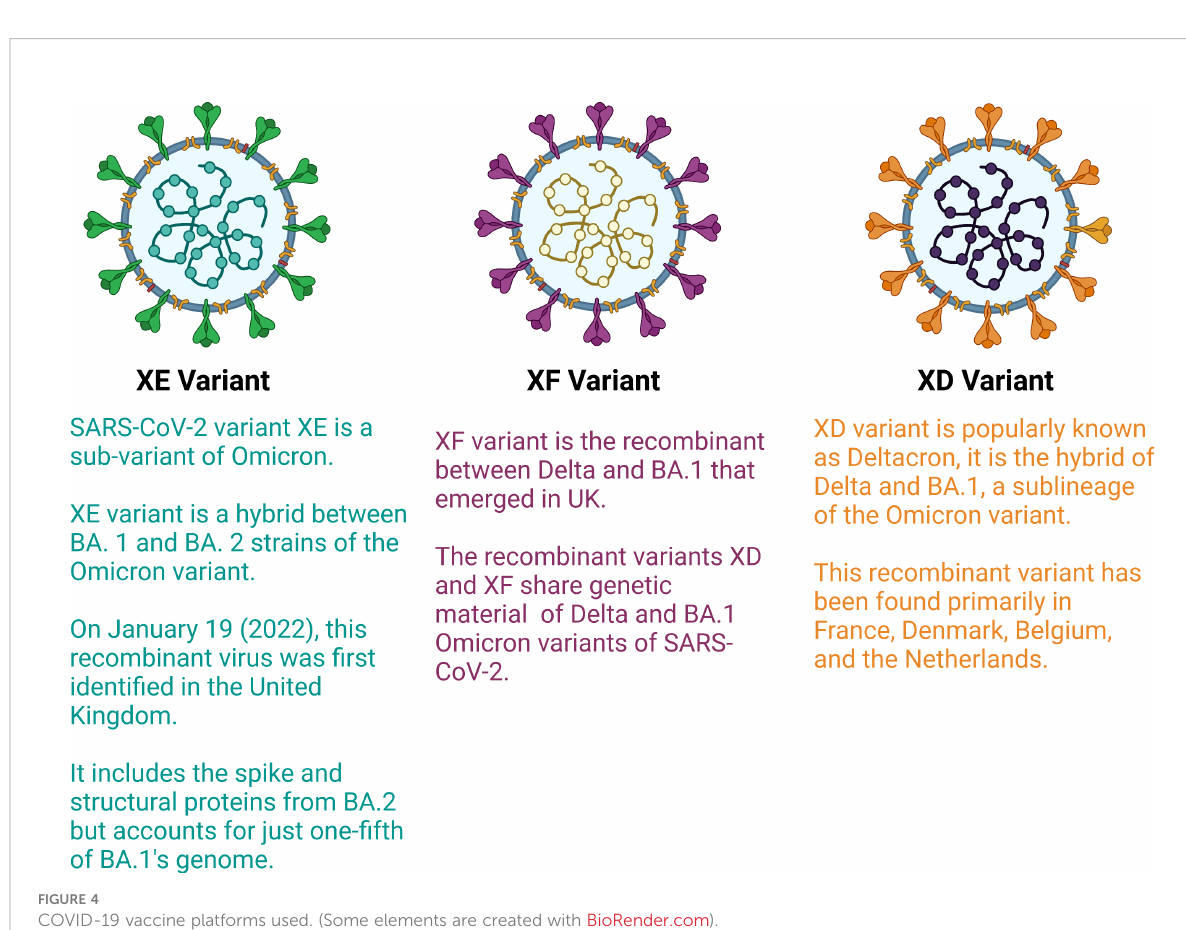
FIGURE 4 COVID-19 vaccine platforms used. (Some elements are created with